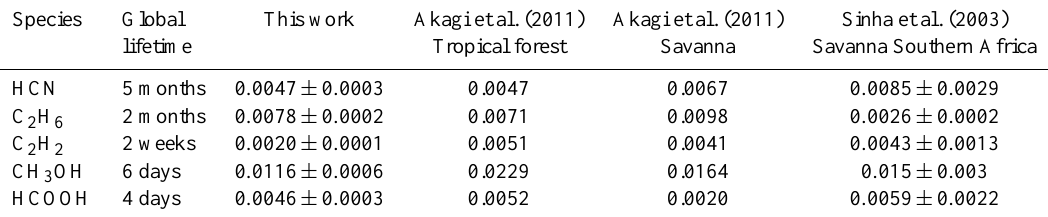
Table 3. Enhancement ratios with respect to CO from this work. Also listed for comparison, the emission ratios with respect to CO from aircraft measurements over savanna fires in Southern Africa (Sinha et al., 2003), and derived from emission factors given in Akagi et al. (2011) (see text for details). The approximate tropospheric global lifetimes of each species are also given. The lifetime of CO is about 2 months (Xiao et al.,